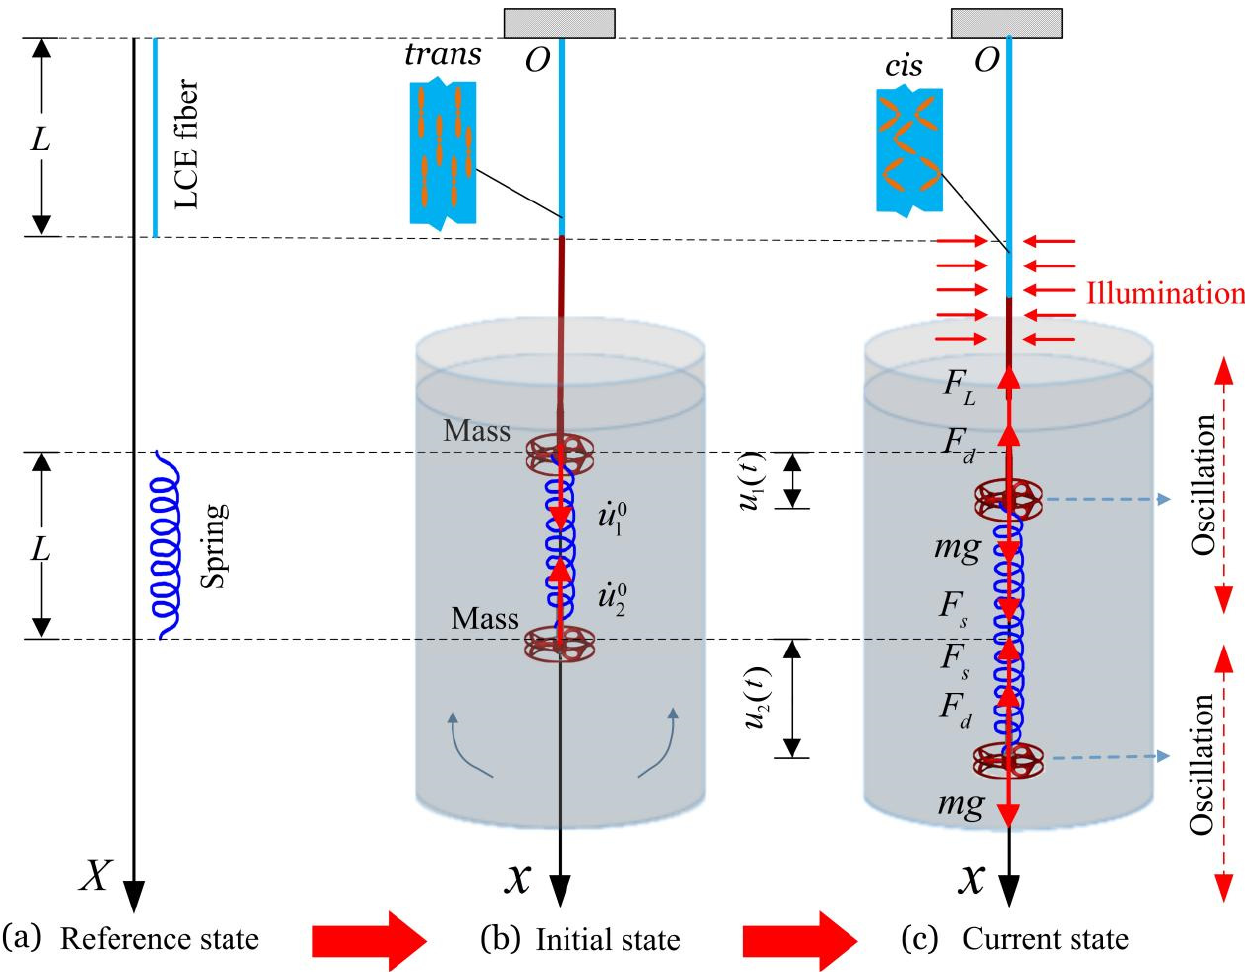
Figure 1. Schematic of a self-oscillating system composed of a passive spring oscillator and an LCE active self-oscillator powered by steady illumination. Both the LCE fiber and spring are connected to each mass block. The two mass blocks are placed into a fluid, and the damping coefficient can be easily tuned by controlling the viscosity of the fluid. Under steady illumination, the two coupled oscillators may vibrate synchronously.